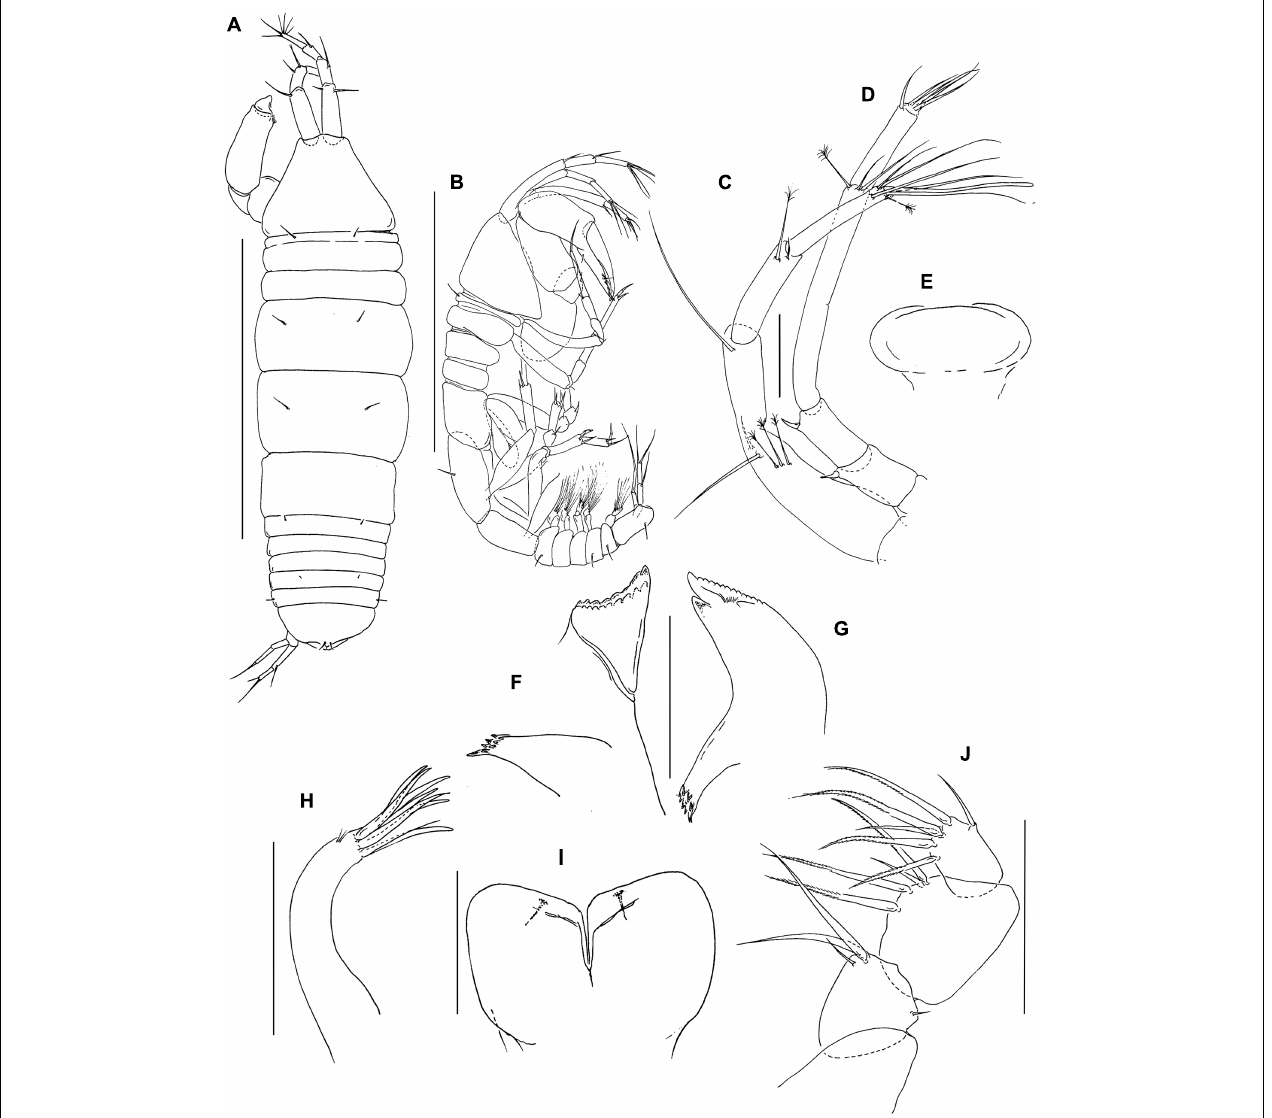
FIGURE 4 | Pseudotanais caberneti sp. nov; female, (J62735) (A) , dorsal; (B) , lateral; (C) , antennule; (D) , antenna; (E) , labrum; (F) , left mandible; (G) , right mandible; (H) , maxillule; (I) , labium; (J) , maxilliped palp. Scale lines (A,B) = 1 mm, (C–J) = 0.1 mm.